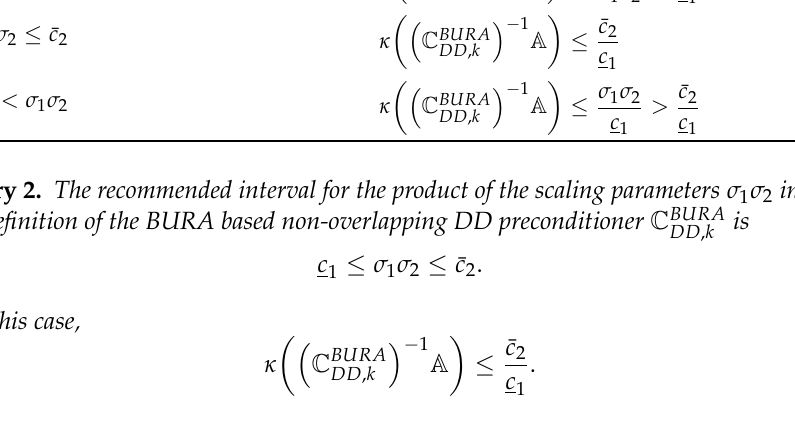
on the product of scaling parameters σ 1 σ 2 .